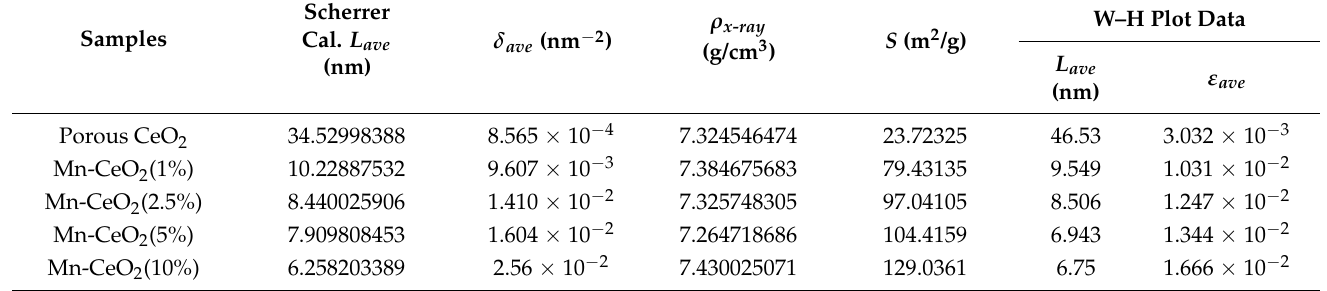
Table 3. Estimated values of size ( L ), dislocations ( δ ), strain ( ε 200 ), and x-ray density ( ρ x-ray ) and surface area ( S ) for all Mn-CeO 2